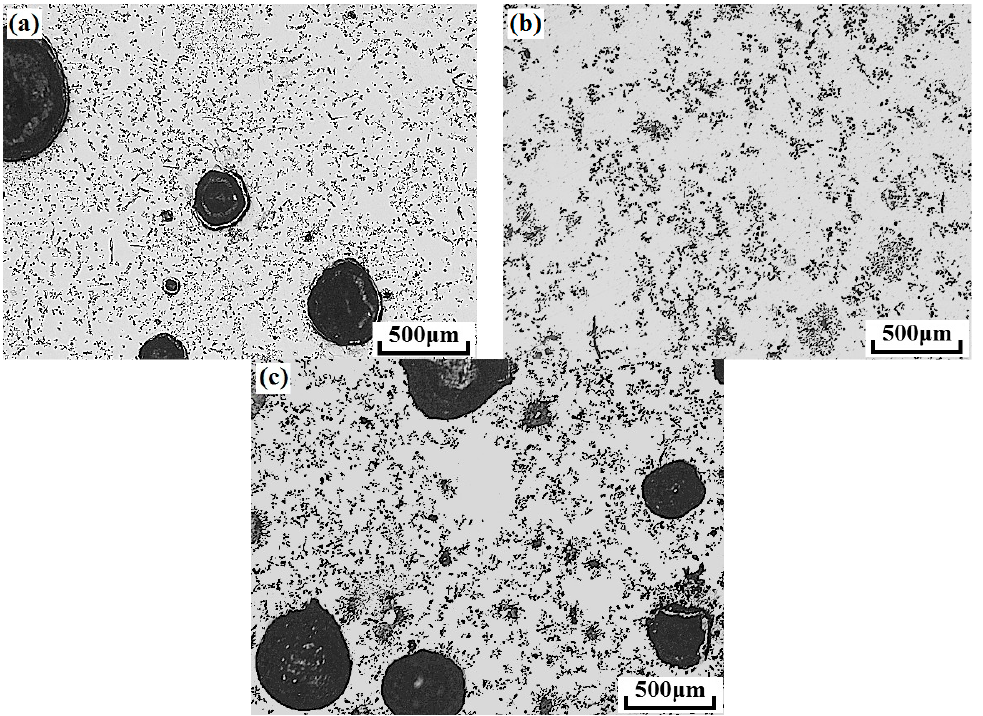
Figure 9. Microstructure of Cu ‐ 14Fe alloys with various solidification techniques. ( a ) Technique I, ( b ) Technique II, and ( c ) Technique III.